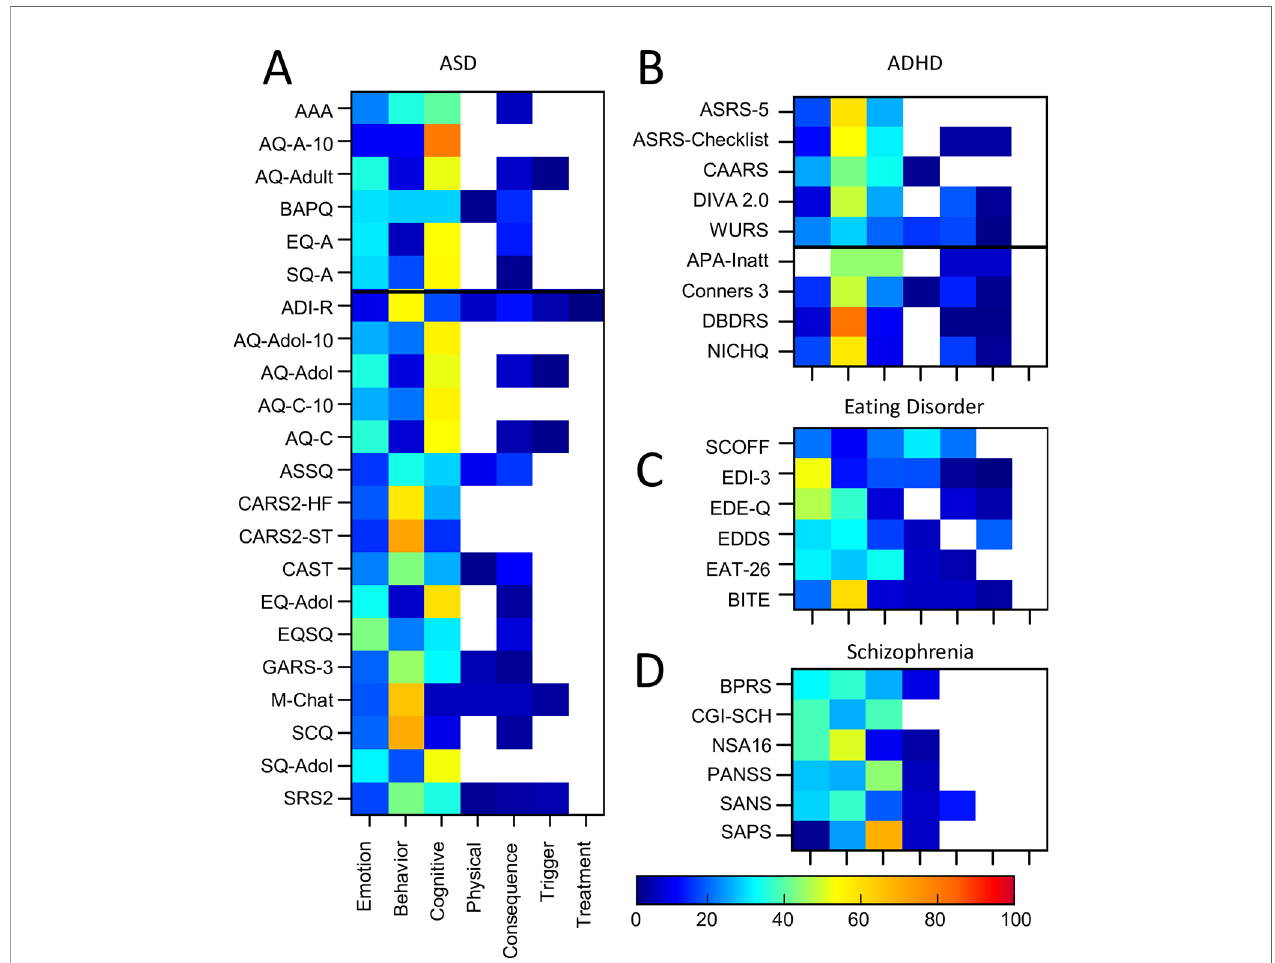
FIGURE 7 | Proportion of symptom themes. Proportion of symptom themes (%) across individual assessment tools within individual disorders (continued). (A) ASD. (B) ADHD. (C) Eating Disorder. (D) Schizophrenia. Black line denotes delineation between adult (top) and pediatric (bottom) tools. See Supplementary Table 5 for a list of